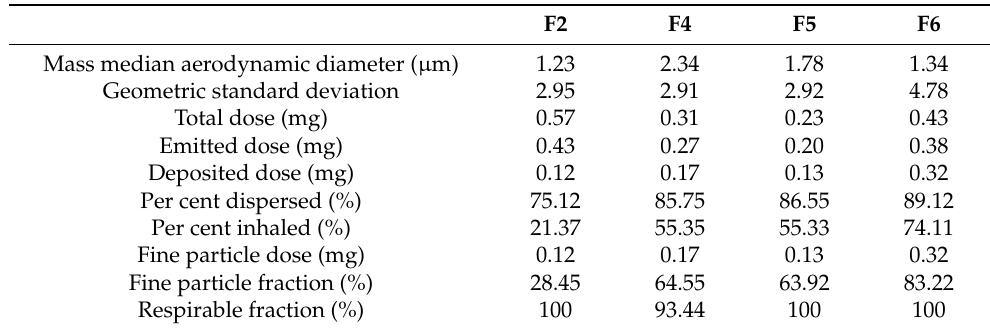
Table 5. Aerosolisation and inhalation profile of chitosan nanoparticles admixed with spray-dried lactose